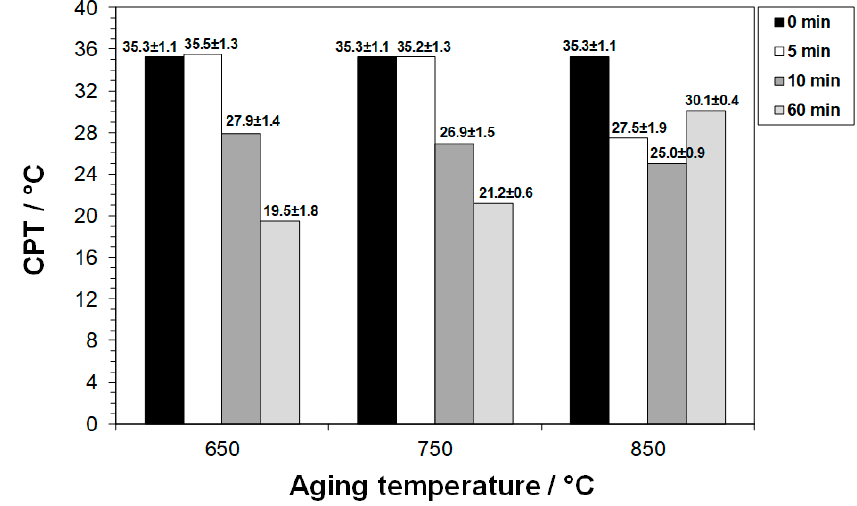
Figure 5. Average critical pitting temperature (CPT) values and standard deviations determined in 0.1 M NaCl solution for both as-received and aged DSS 2304.